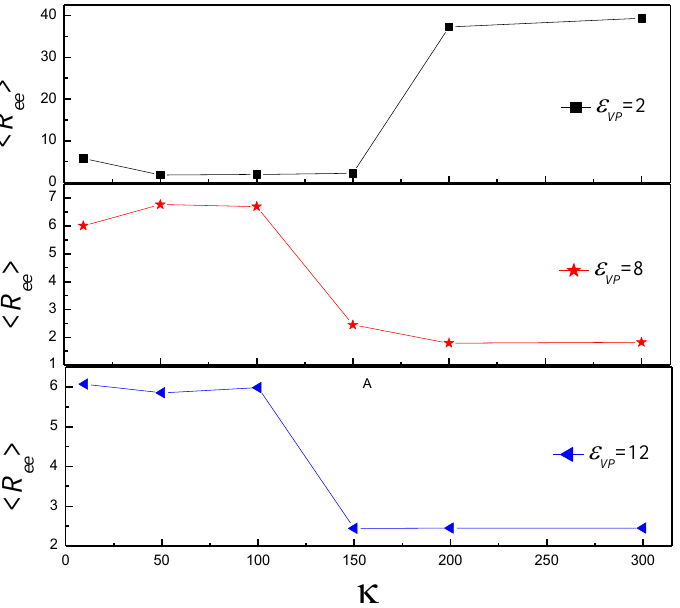
Figure 3. The mean end-to-end distance < R ee > versus bending stiffness κ for ε VP = 2, 8, and 12.